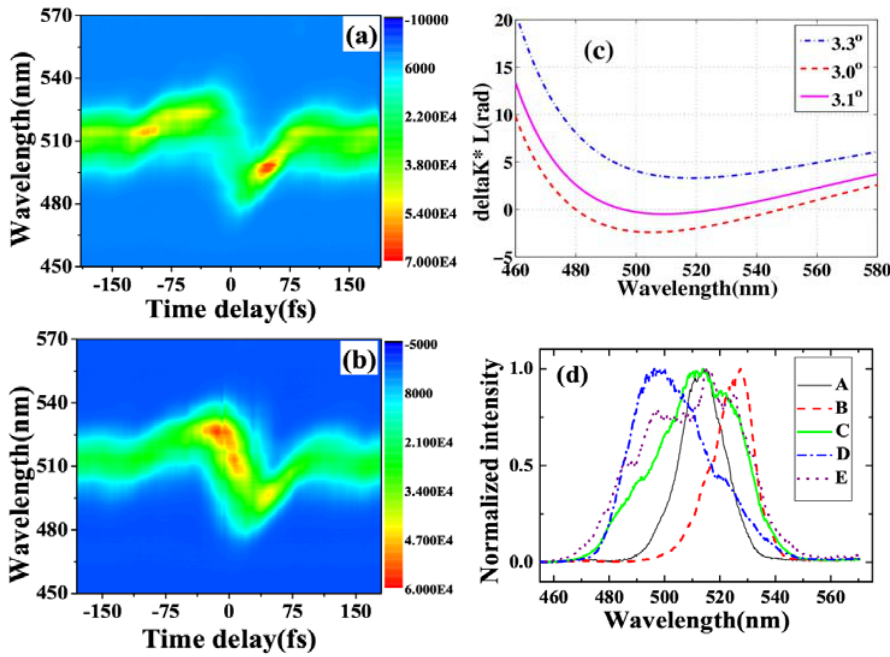
Figure 33. Dependence of the spectral profile and intensity of the output seed beam (AS1) for crossing angles α of (a) 1.80º ± 0.05º and (b) 3.30º ± 0.05º. (c) The on the delay time t ps phase mismatch curves at three different external crossing angles (3.3º, 3.1º, and 3.0º) in a 0.5mm-thick fused silica glass when the seed pulse was centered at 510 nm and pumped by 800 nm pulse. (d) A: the incident spectrum of seed pulse. B, C, and D are the spectra of output pulse at delay times of –30, 0, and 30 fs when α was 3.30º ± 0.05º, respectively. E: the spectra of output pulse at delay times of 0 fs when α was 1.80º ± 0.05º